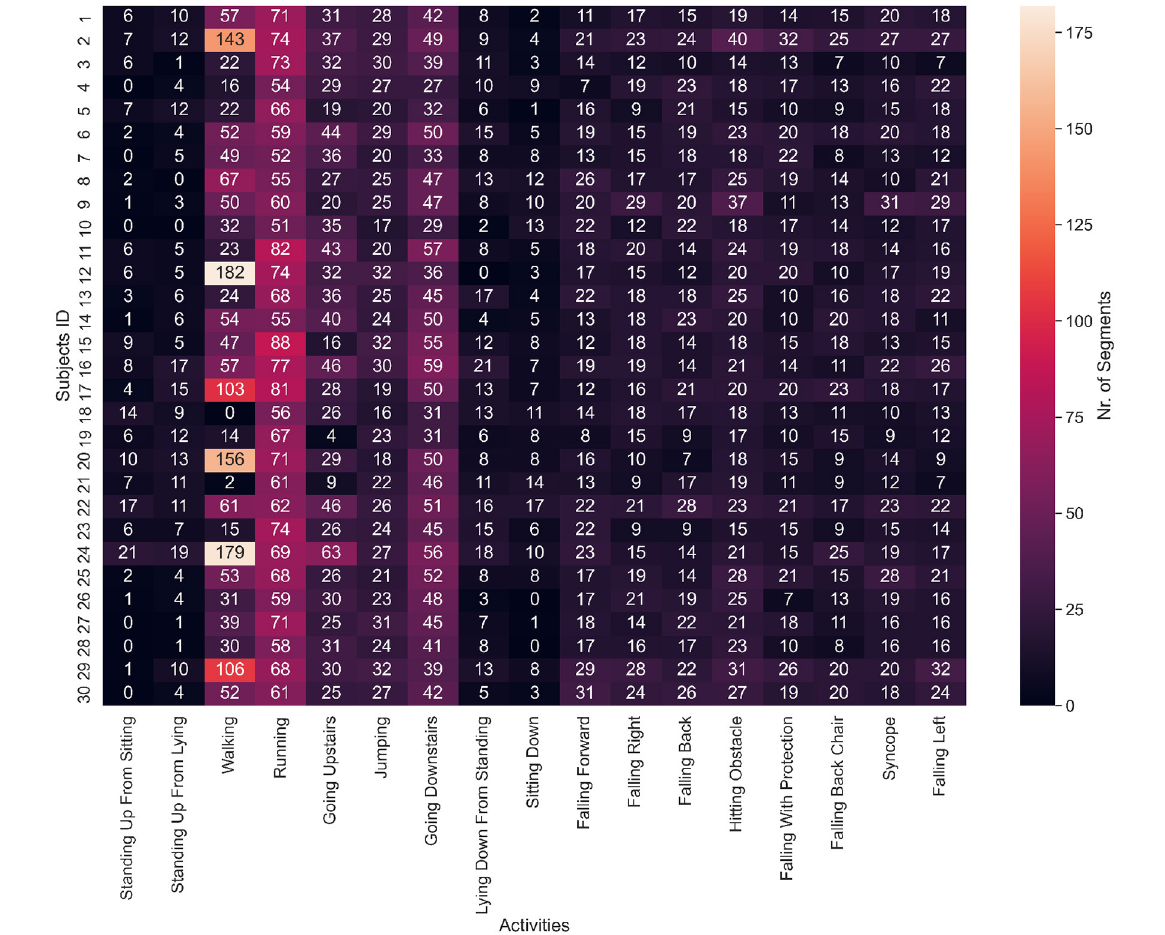
network, the use of dropouts, the number of segments (11,771), and the number of epochs (120) lead to high training time. From an evaluation perspective, cross-validation, and especially leave-one- subject-out (LOO), is time expensive, as the network may need to be retrained up to 30 times. Overall, the training and evaluation for each method can range from an hour to 2 days in the LOO